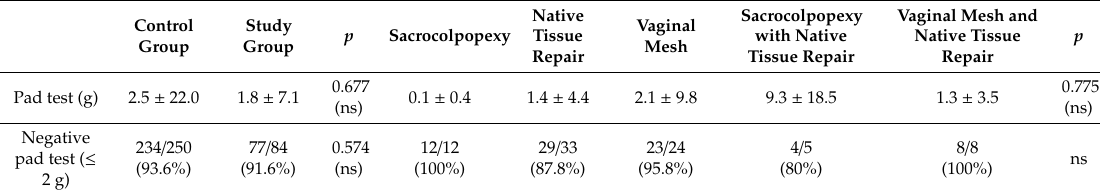
Table 5. The results of the 1-h pad test in both groups 6–12 months after TVT sling implantation, with regard to the type of reconstructive surgery.